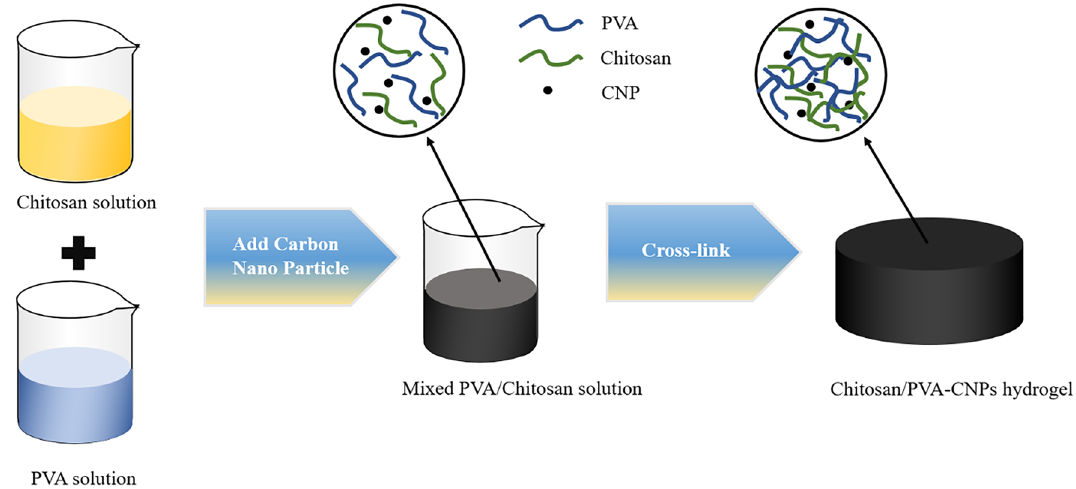
Figure 3. Fabrication process of CPC